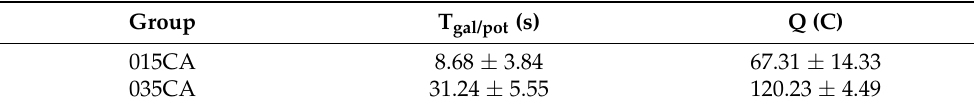
Table 2. T gal/pot and electric charge (Q) for MAO-treated